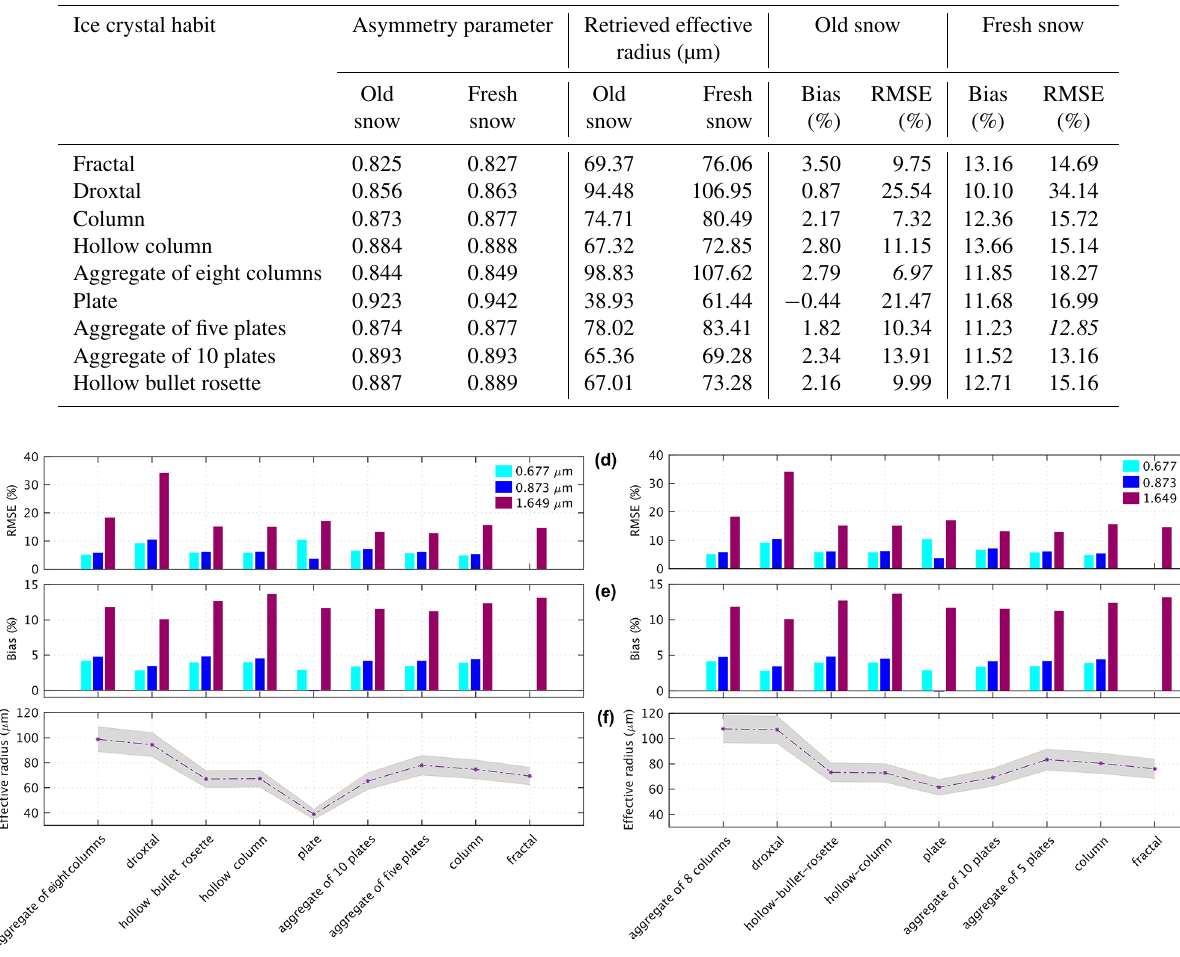
Figure 8. Comparison of snow grain size retrieval and best fit of reflectance at three wavelengths of 0.677, 0.873, and 1.649µm. (a, b, c) Old snow case and (d, e, f) fresh snow case. Effective radius is retrieved at 1.649µm, and the gray envelope (shading) shows the uncertainty in the retrieved effective